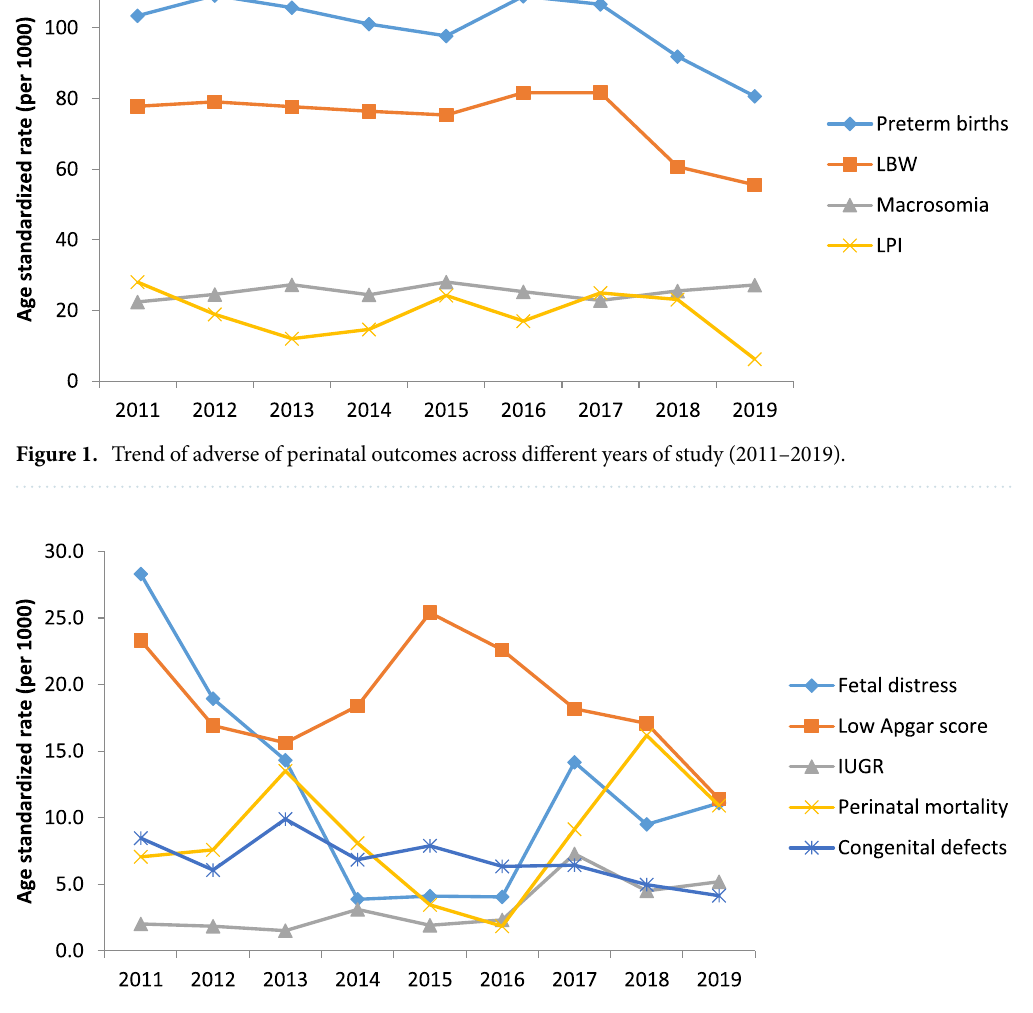
Figure 2. Trend of adverse perinatal outcomes across different years of study